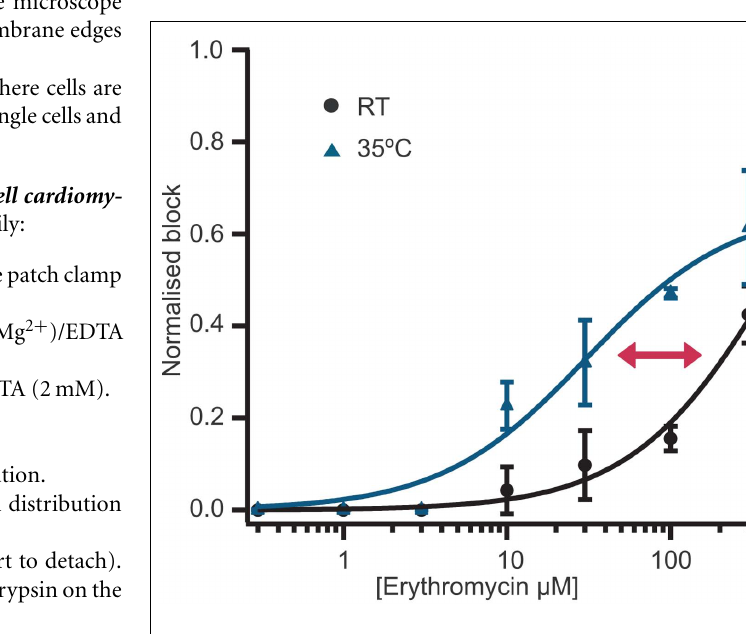
FIGURE 2 | Concentration response curves for erythromycin at room temperature ( n = 12) and at 35˚C ( n = 18). Erythromycin is approximately 10-fold more potent at 35˚C compared with room temperature. An overlay of the concentration response curves at room temperature and 35˚C clearly shows the shift in